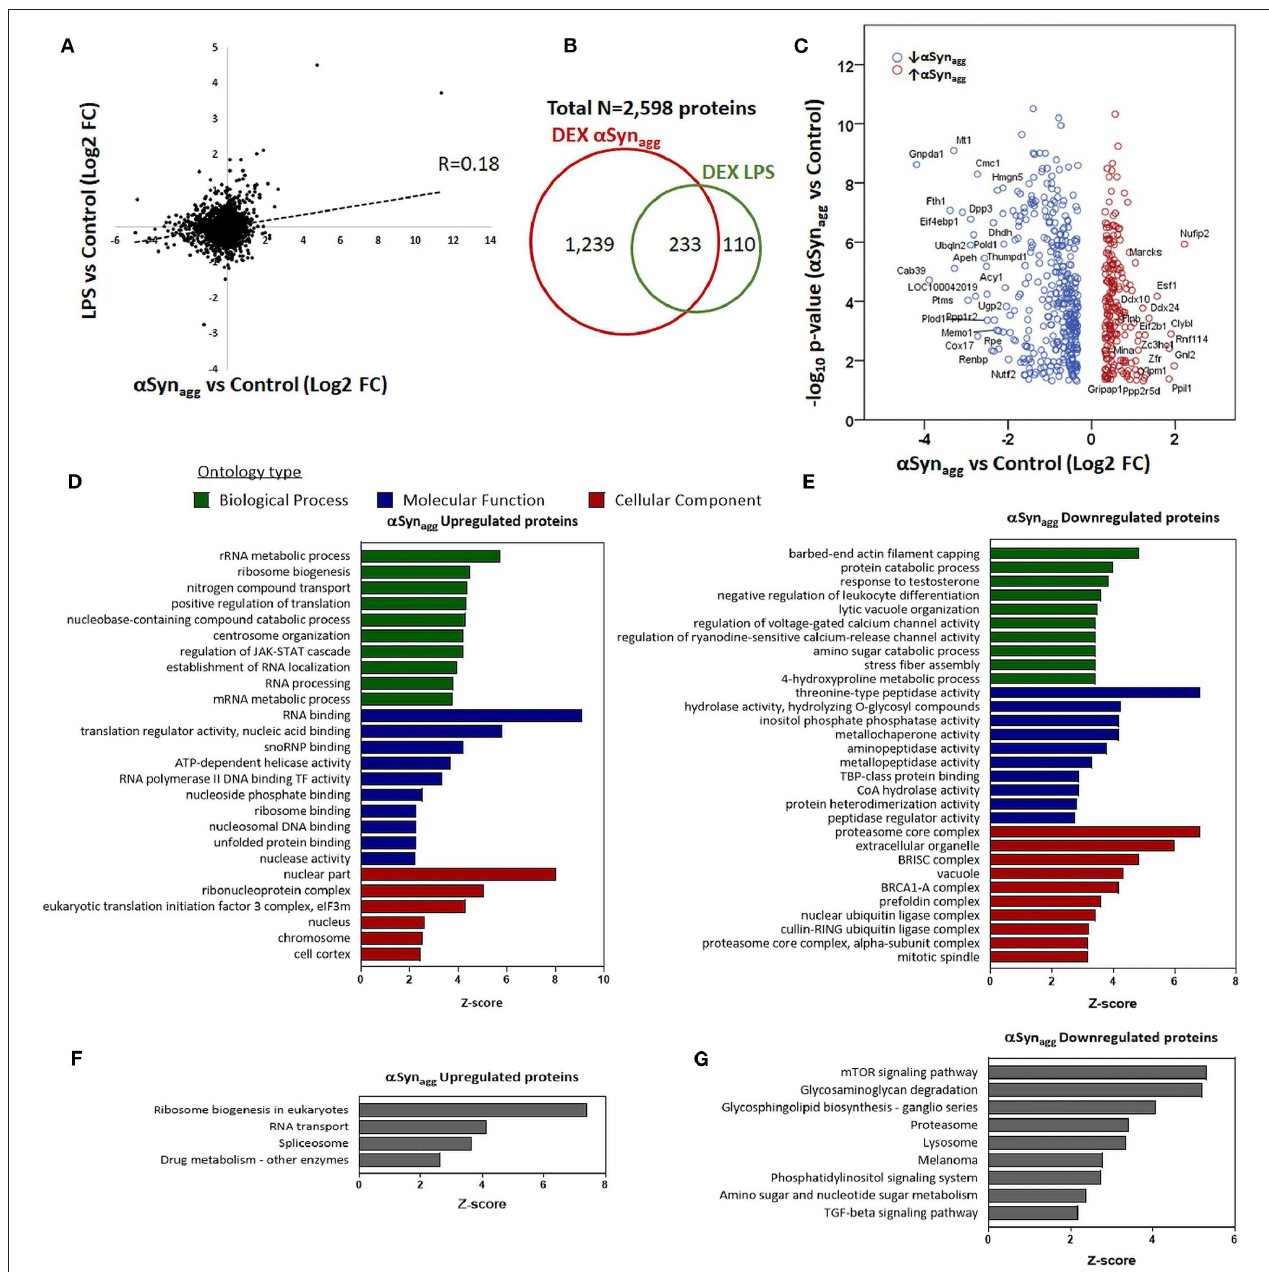
FIGURE 3 | Comparison of Syn-induced and LPS—induced microglial proteomic changes in mouse microglia. (A) Correlation between fold-changes in protein expression comparing α Syn Agg vs. control with LPS vs. control microglial proteomic datasets. Pearson’s Rho is shown. (B) Venn diagram showing degree of overlap between proteins differentially expressed (DEX) in response to α Syn Agg and LPS in mouse microglia. (C) Volcano plot of proteins that are differentially expressed in response to α Syn Agg but not by LPS (defined as at least 1.25-fold change and p < 0.05 in response to α Syn Agg but p > 0.2 in response to LPS). The labeled proteins in the volcano plot are the significant hits. (D,E) Gene Ontology enrichment analyses of uniquely Syn-upregulated proteins in microglia ( D : GO terms, E : KEGG pathways). (F,G) Gene Ontology analysis of uniquely Syn-downregulated proteins ( F : GO terms, G : KEGG pathways). For panels d-g, only top 10 enriched GO or KEGG pathway terms that met significance criteria (enrichment Z-score > 1.96) are